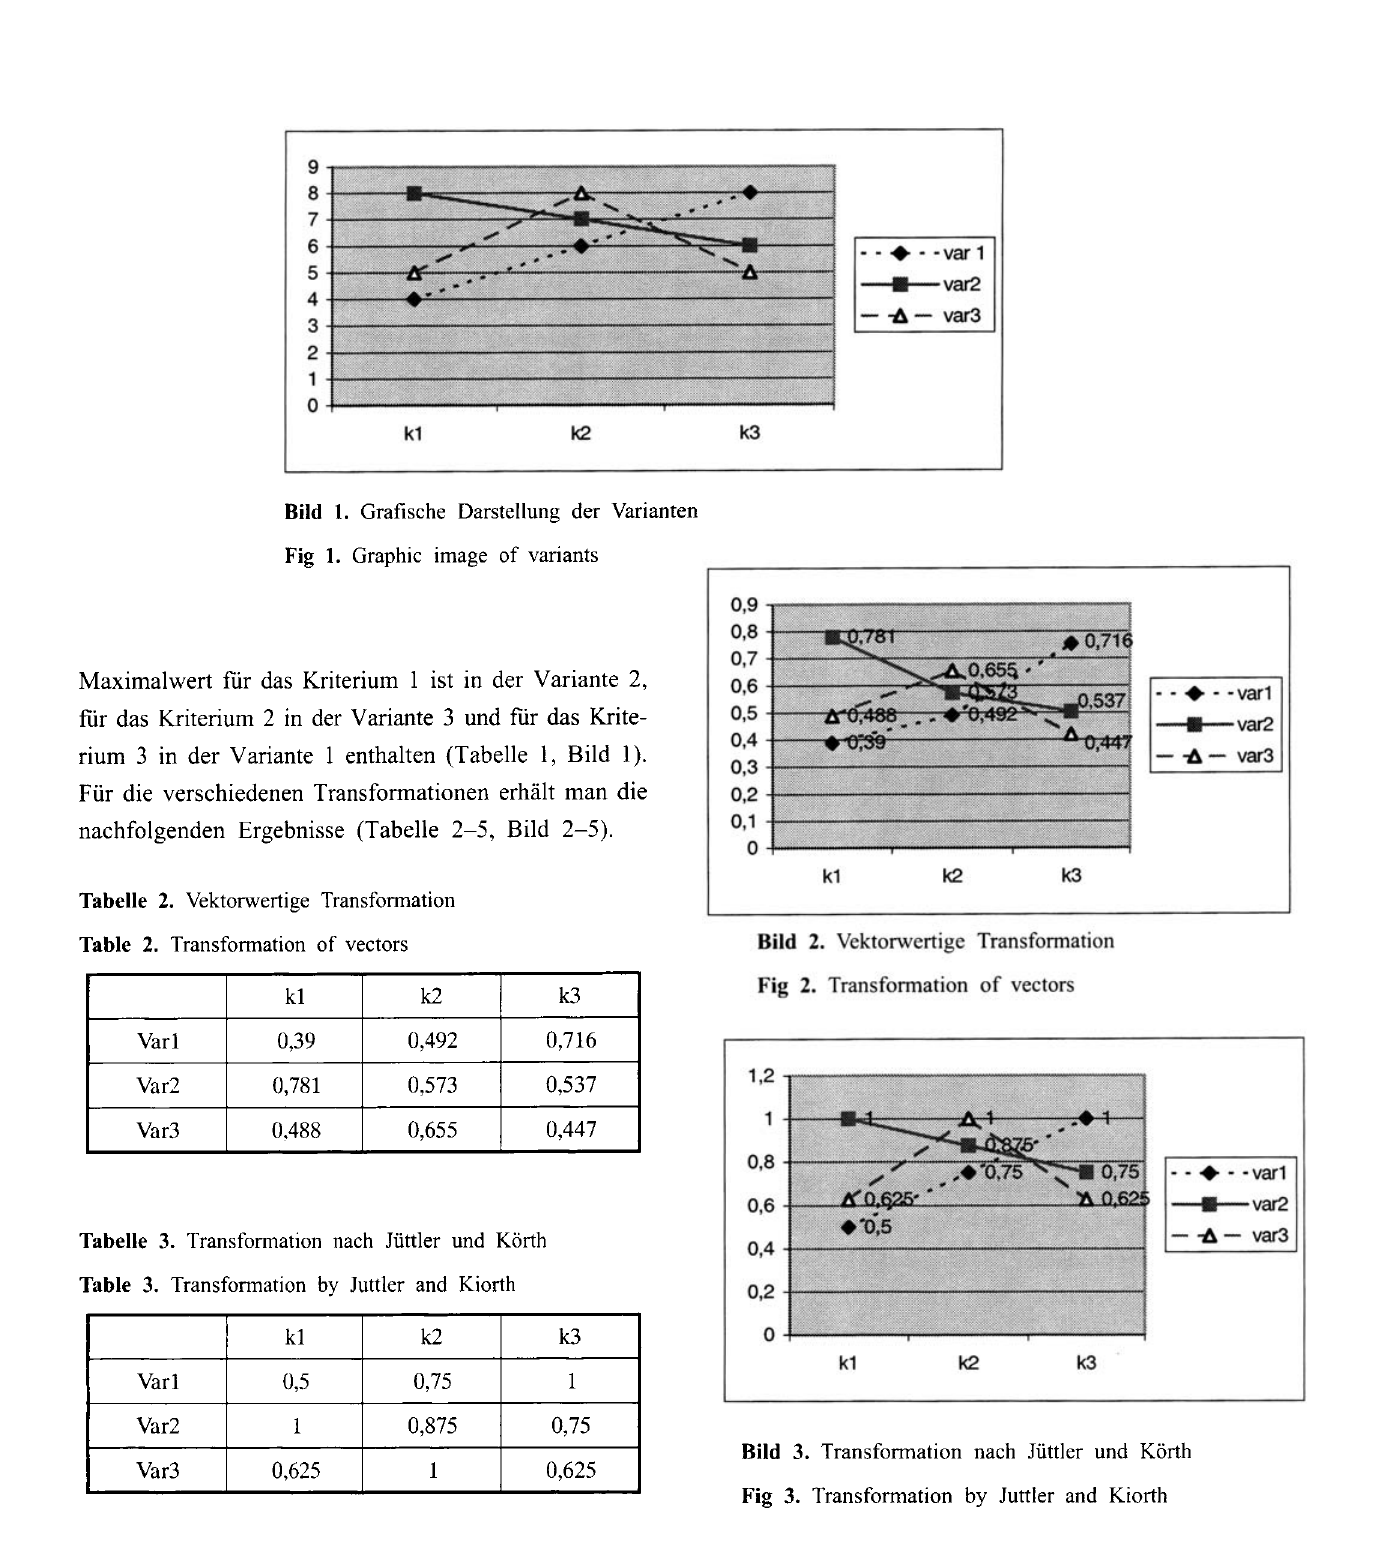
Fig 3. Transformation by Juttler and